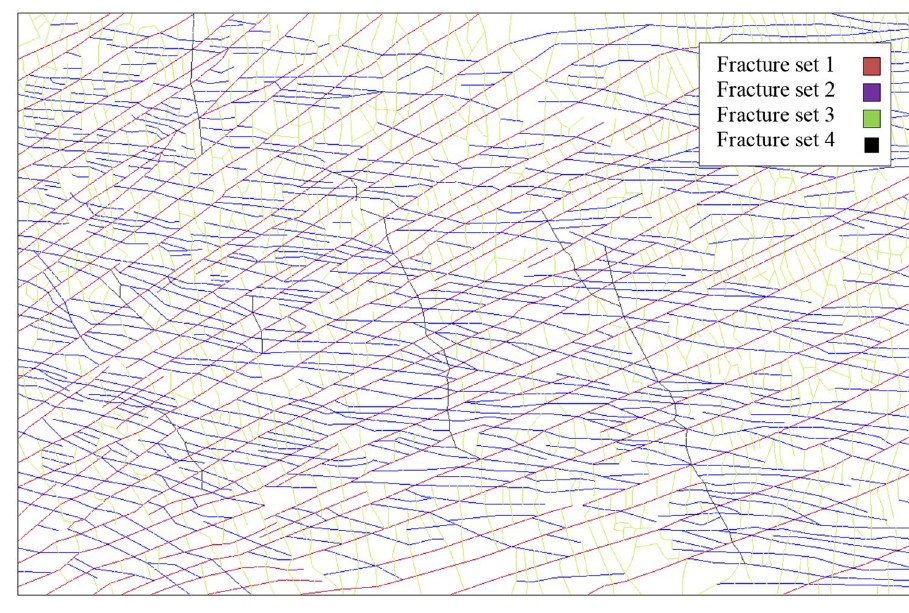
Fig. 3 Planview of Arches, 1400 × 800 m Entrada sandstone fracture pavement model built from outcrops in Arches National Park, Utah (USA), mapped using Google Earth imagery (Matthai et al. 2012)